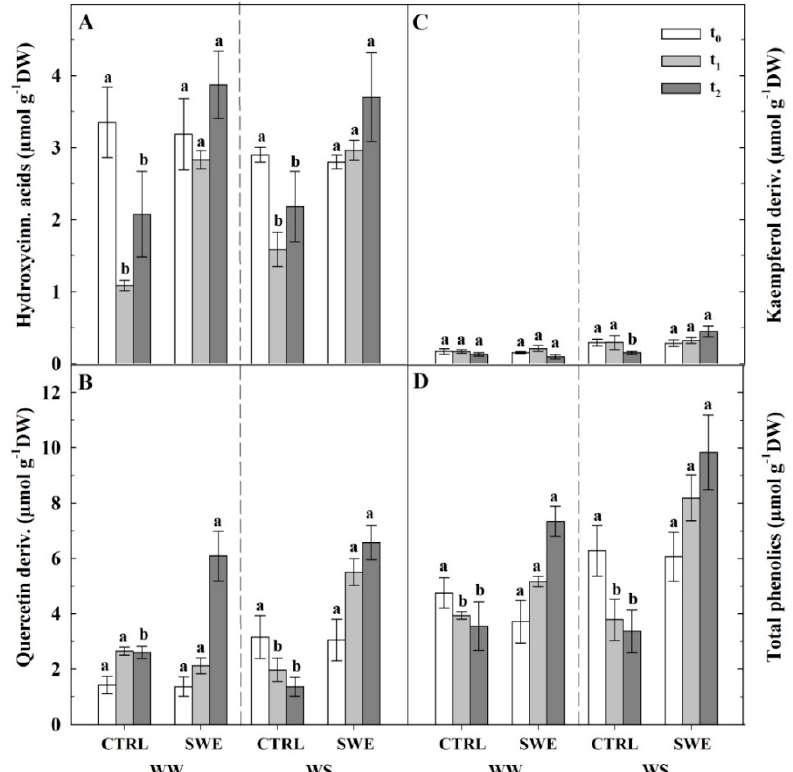
Figure 5. Berry skin hydroxycinnamic acids and flavonols in V. vinifera treated with A. nodosum extract (SWE) and untreated plants (CTRL) under two irrigation regimes (WW, well-watered; WS, water stressed). ( A ) Hydroxycinnamic acids, ( B ) Quercetin derivatives, ( C ) Kaempferol derivatives, and ( D ) Total phenolic contents. Means (±SE, n = 5) followed by distinct letters within the same water regime and sampling time are significantly different according to the LSD test ( p ≤ 0.05). Measurements were conducted at t 0 (white bar), t 1 (grey bar), and t 2 (dark grey bar).